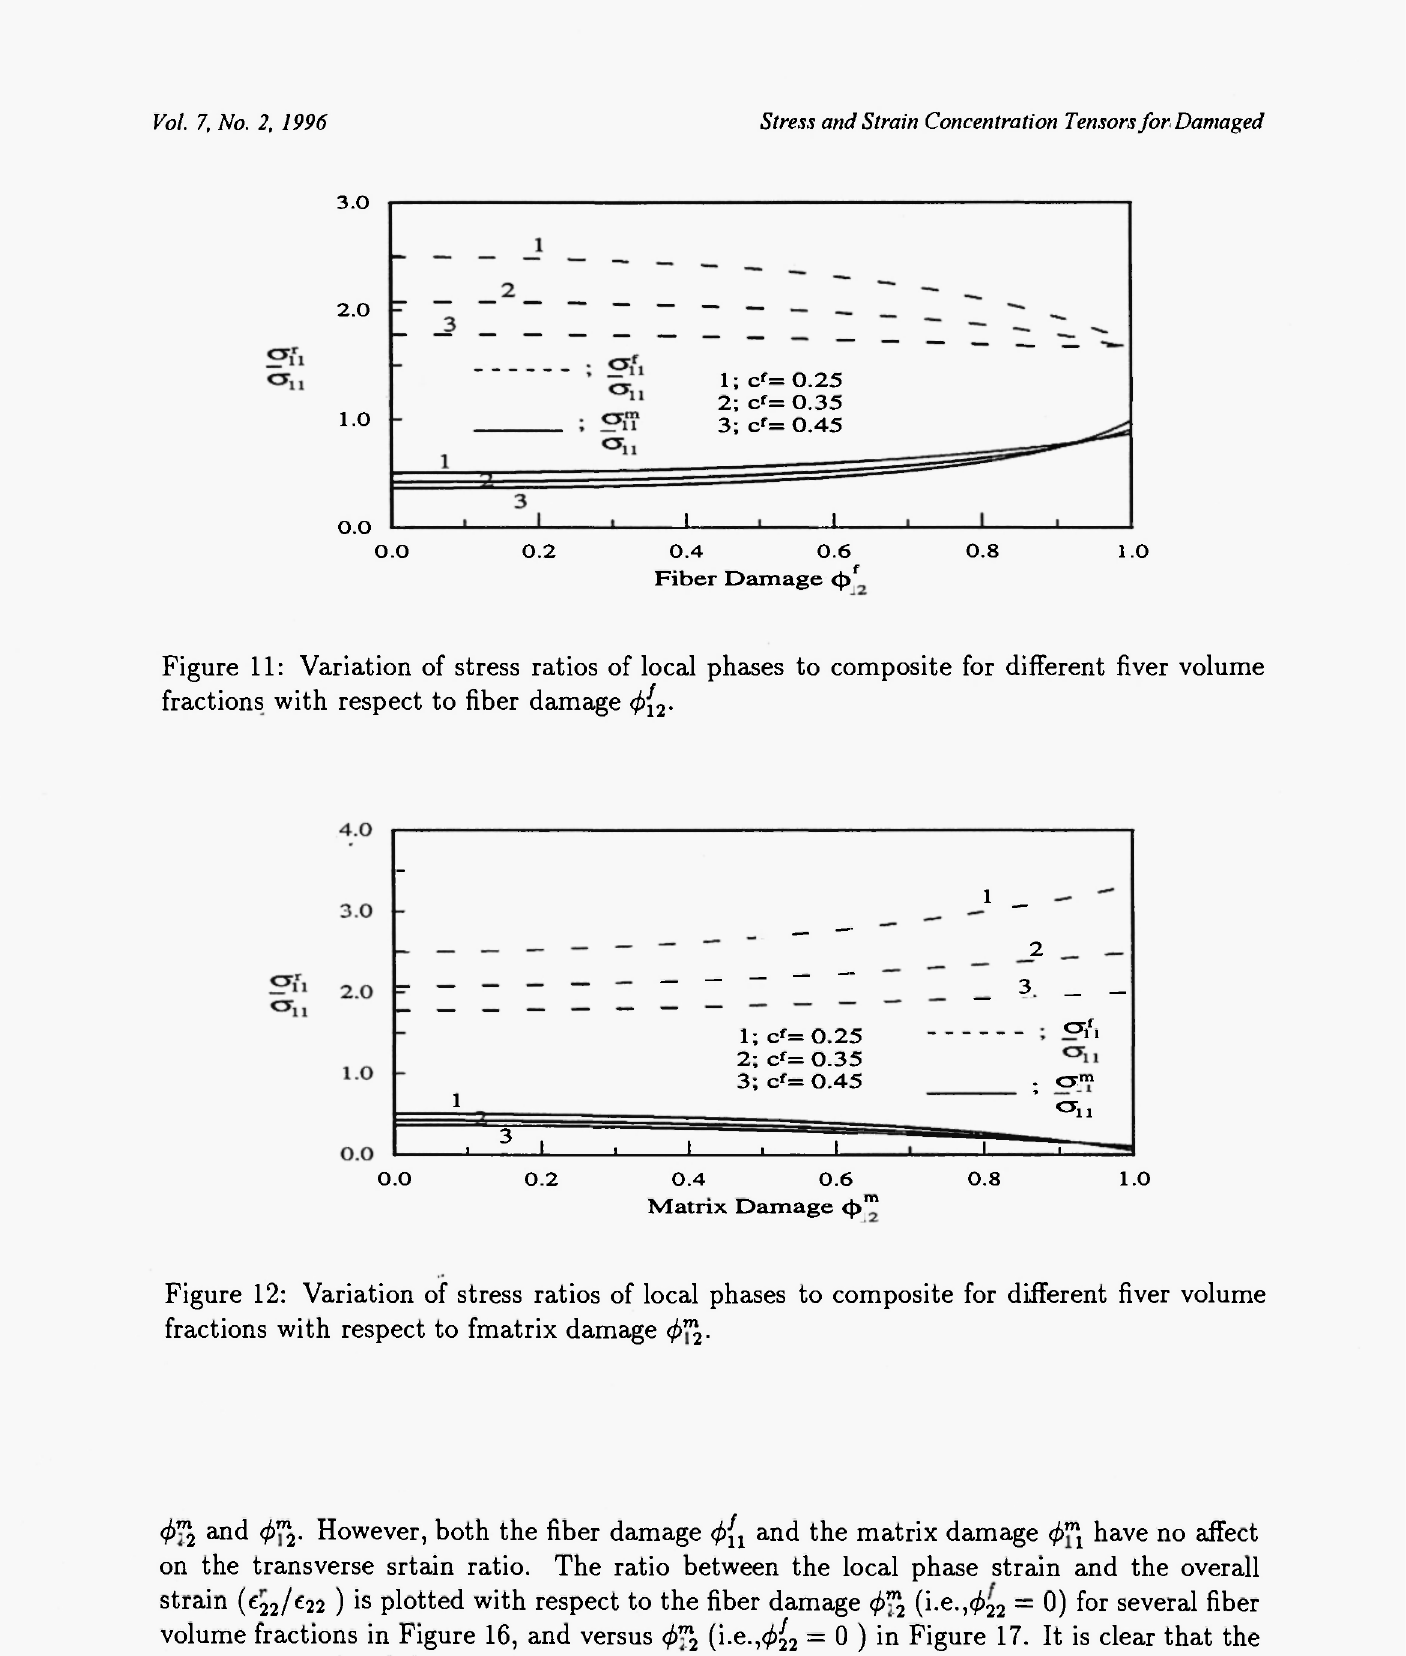
transverse strain of the constituent increases due to its